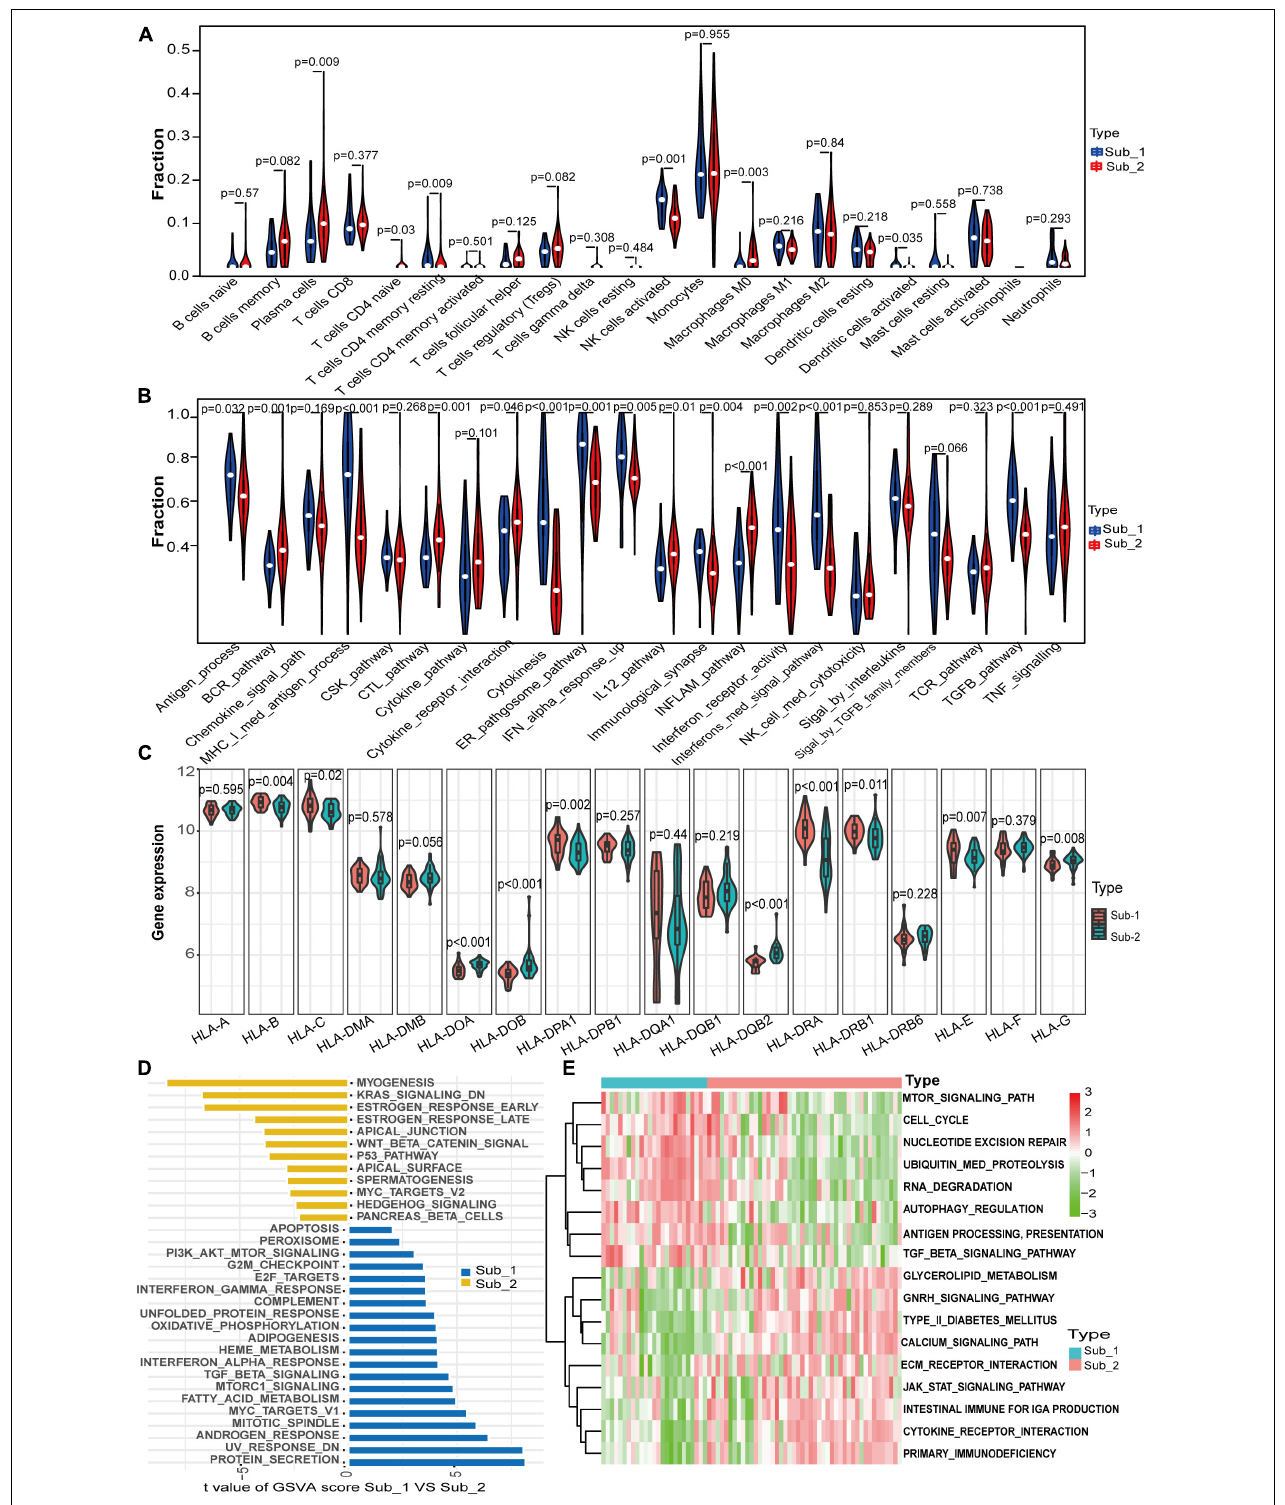
FIGURE 6 | Differences in immune characteristics between m 6 A subtypes and functional enrichment analysis in two m 6 A subtypes. (A) Differences in abundance of 22 infiltrating immunocytes. (B) Differences in the activity of 22 immune response gene sets in two m 6 A subtypes. (C) Expression differences of 18 HLA genes in two m 6 A subtypes. (D) Differences in HALLMARKS pathway enrichment between m 6 A subtypes. (E) KEGG pathways with significant differences in enrichment between m 6 A subtypes.